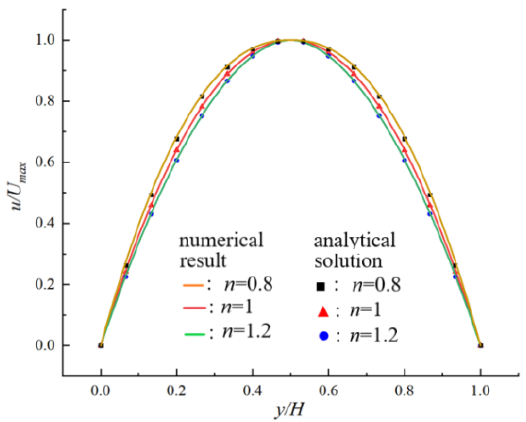
Figure 2. Comparison of numerical results.